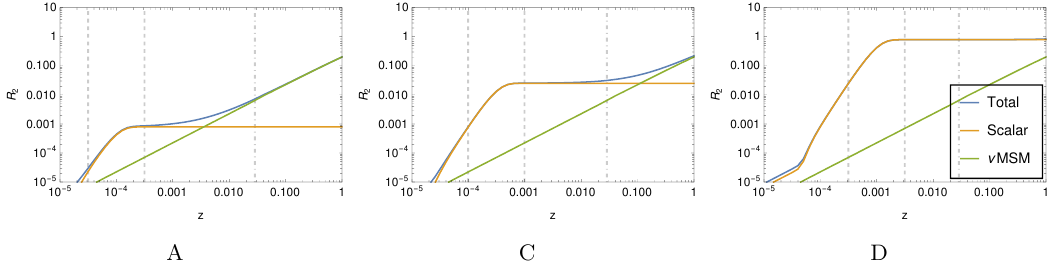
Figure 3. Production of the sterile neutrino density R N as a function of the time parameter z for the benchmark points A, C, D. The orange and blue line denotes total N production and N production via process a , respectively. The green line denotes sterile neutrino production from ν MSM dynamics. The vertical dashed lines indicate the time where S decays are relevant, the dashed-dotted lines correspond to z = z osc = 0 . 028 .